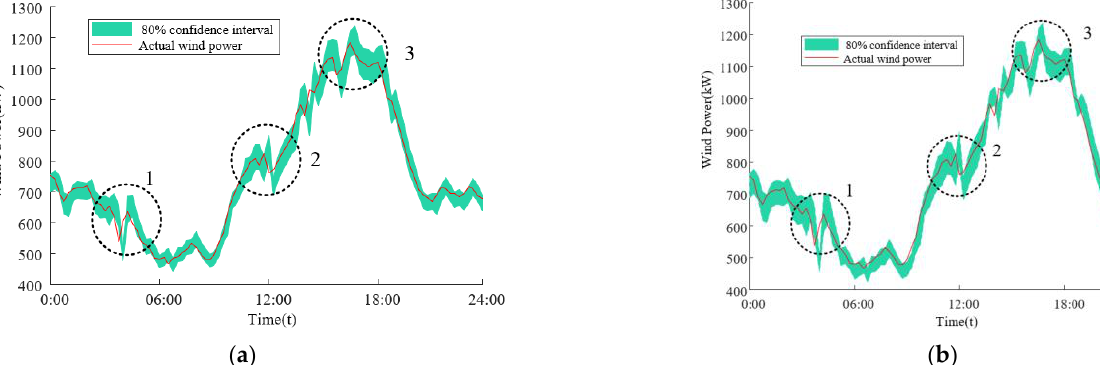
Figure 8. Power interval before correction and after correction. ( a ) Power interval before correction; ( b ) Power interval after correction.